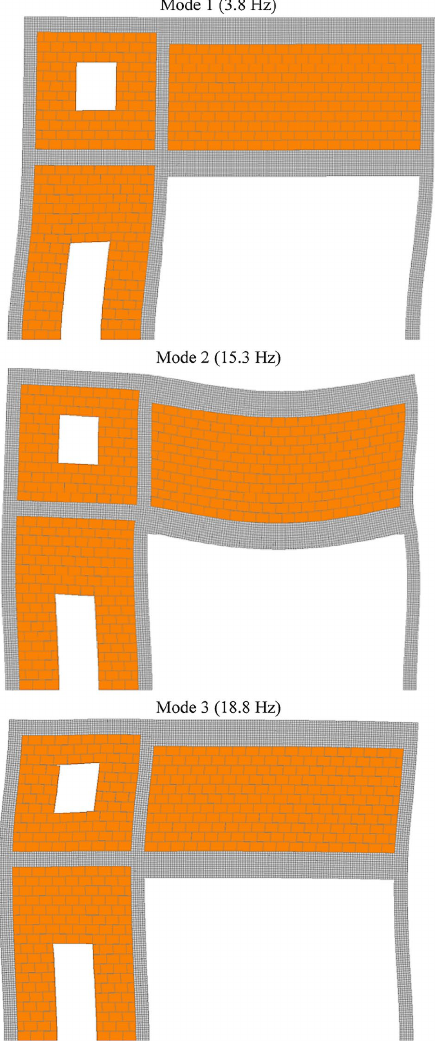
Fig. 13. Natural frequencies and vibration shape mode results of the analysis no. 10 (FCEM with infill walls), for the first vibration